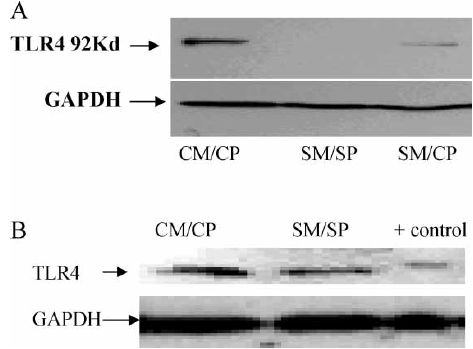
Figure 1. (A) The hepatic TLR4 protein expression is lower in the adult IUGR offspring of prenatal calorie restricted rats. We